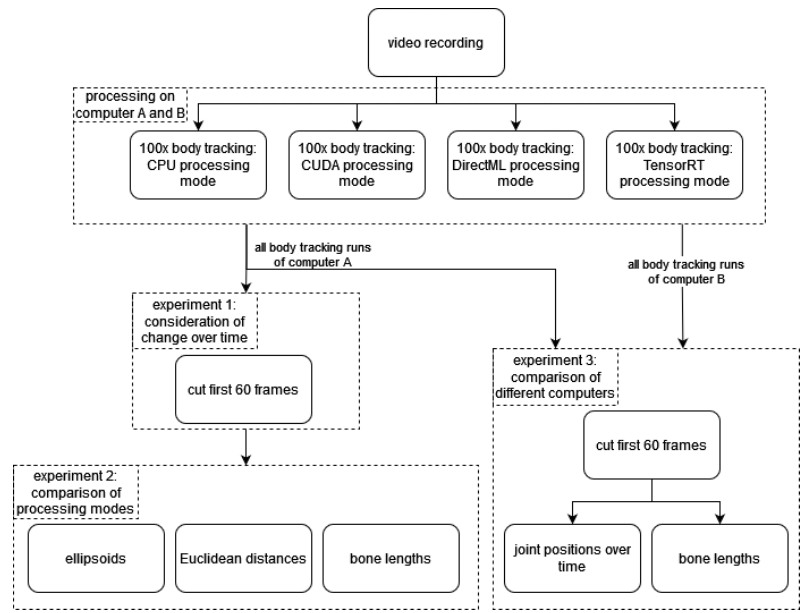
Figure 2. Schematic overview of the data processing and the three